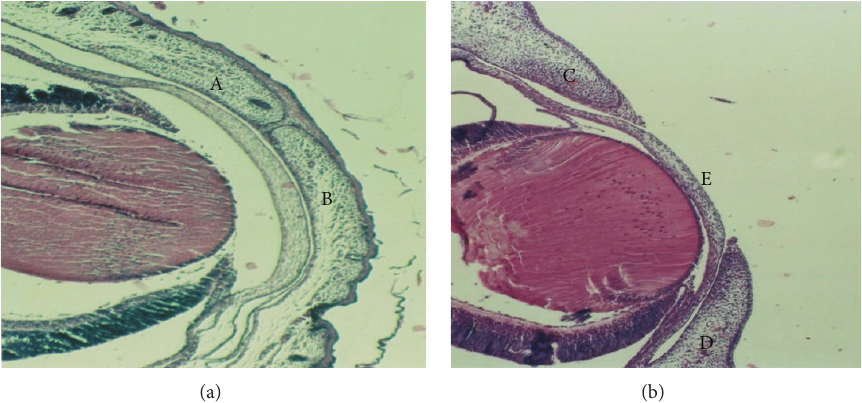
Figure 3: Histopathological slides of the eyes from 17 days fetuses in control group (a) and the group received a combination of clomipramine and caffeine in high doses (b) (H&E staining, 10x). In control group fetus (a), the upper (A) and lower (B) eyelids are joined completely. In the fetus from the group treated with clomipramine and caffeine in high doses (b), the upper (C) and lower (D) eyelids were separated completely and the cornea (E) is